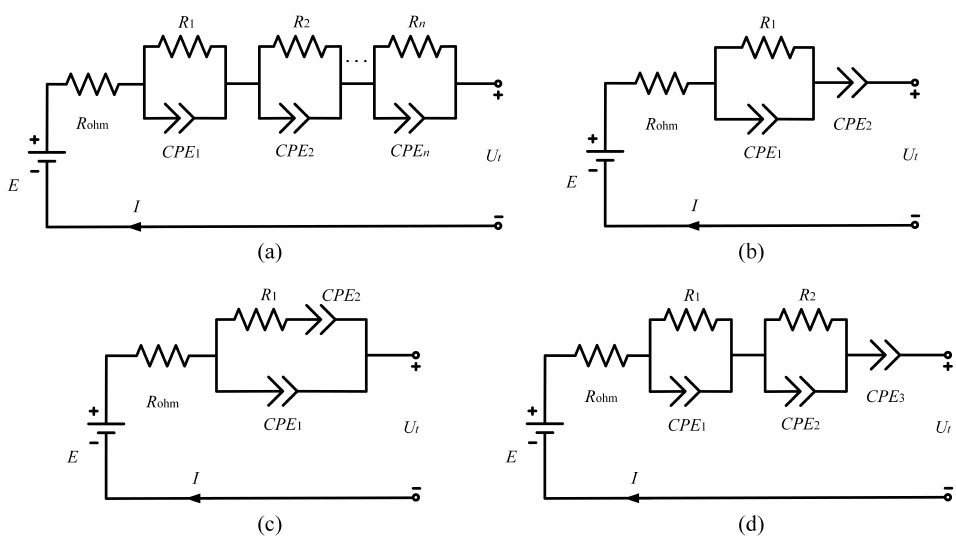
Figure 1. Fractional-order equivalent circuit model of LIBs in various forms, ( a ) n- RC α Model, ( b ) fractional-order PNGV model, ( c ) fractional-order Randles model, and ( d ) three-orders fractional- order model ( CPE i , i = 1,2, . . . , n ).